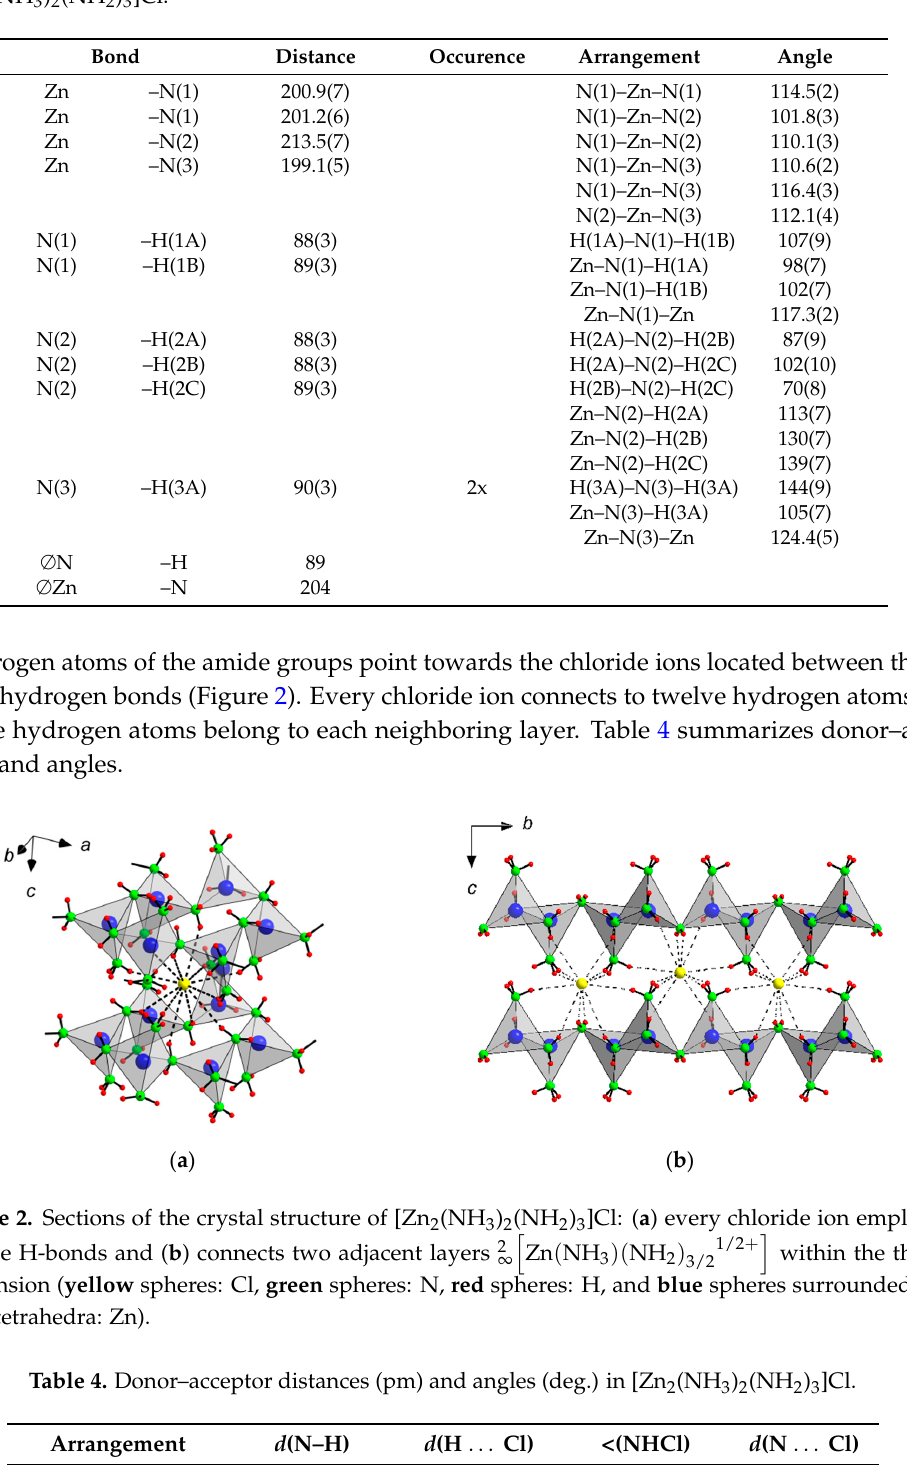
Table 4. Donor–acceptor distances (pm) and angles (deg.) in [Zn 2 (NH 3 ) 2 (NH 2 ) 3 ]Cl. Arrangement